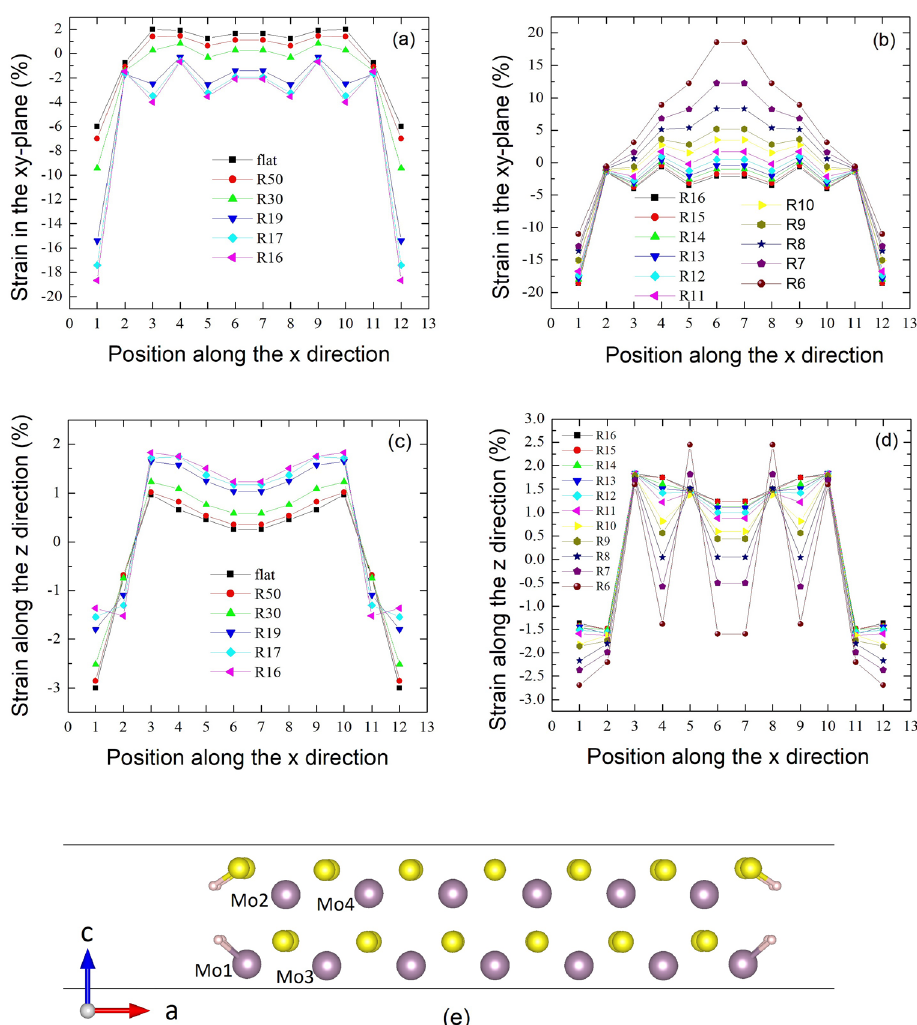
Figure 2. The evolution of strains with curvature radii for the A13MoS 2 nanoribbon and the schematic showing the calculation of the strains. The strain in the xy-plane for the middle Mo atom layer (SXYM) with R from ∞ (flat) to 16 Å in ( a ), and with R = 16Å to 6Å in ( b ). In ( a ) SXYM steadily decreases and gets more negative with R from ∞ to 16 Å . In ( b ) SXYM mostly increases beyond the critical κ c1 = 0.0625 / Å ( R = 16 Å ). R50 represents R = 50 Å and so on. The strain along the z direction for this middle Mo atom layer (SZM) with R from ∞ (flat) to 16 Å in ( c ), and with R = 16 Å to 6 Å in ( d ). The schematic graph showing the atomic